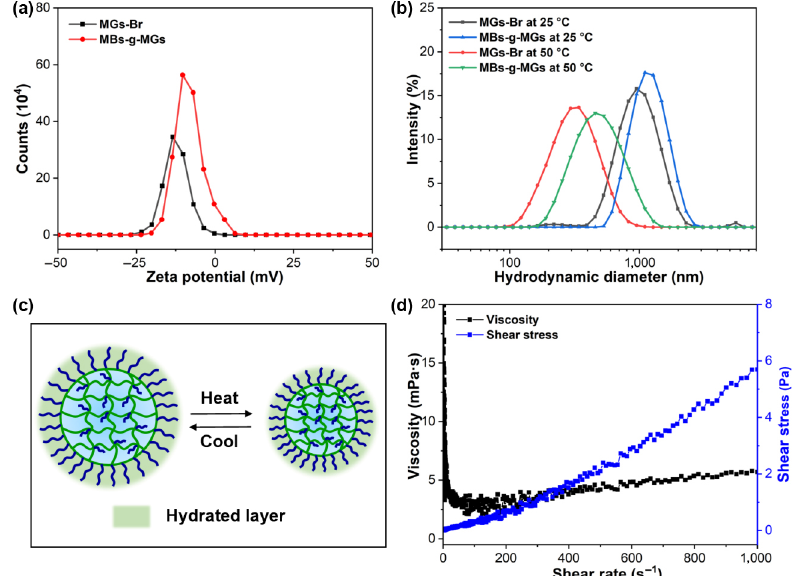
Fig. 5 (a) ζ -potentials of MGs-Br and MBs-g-MGs. (b) Hydrodynamic diameters of MGs-Br and MBs-g-MGs at 25 and 50 °C. (c) Schematical diagram illustrating the phase shrinkage and the surficial wetting change at different temperatures. (d) Viscosity and shear stress vs. shear rate curve of MBs-g-MGs